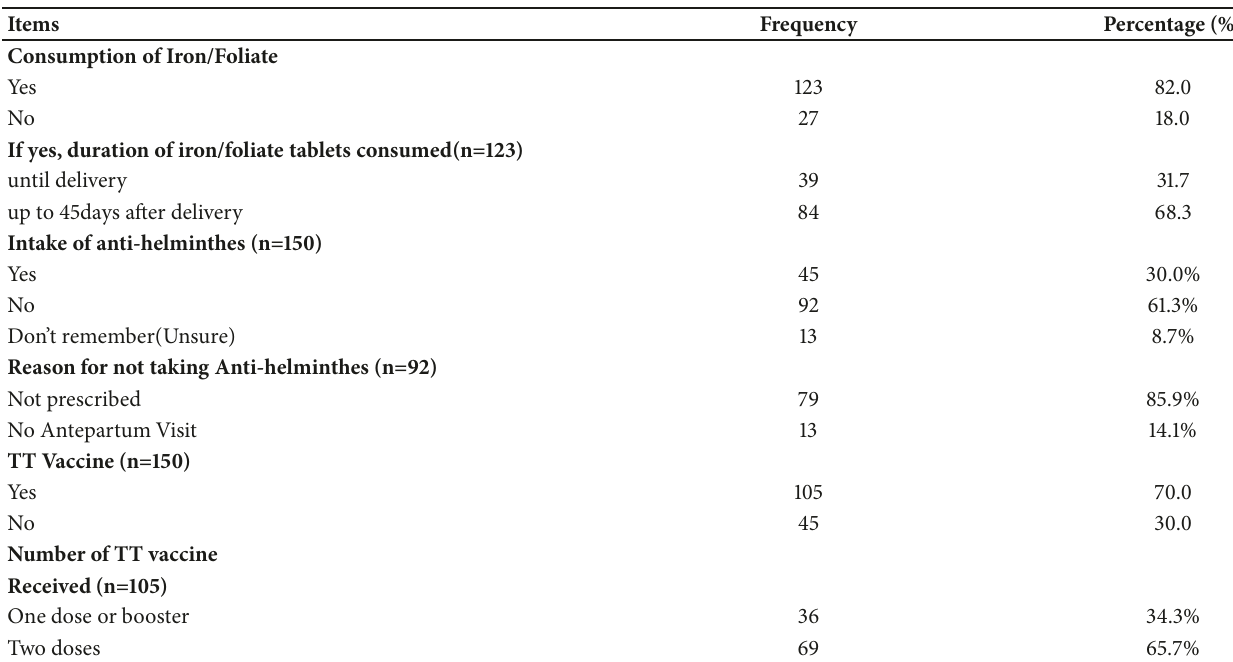
Table 3: Respondents’ utilization of medicines during antepartum period.